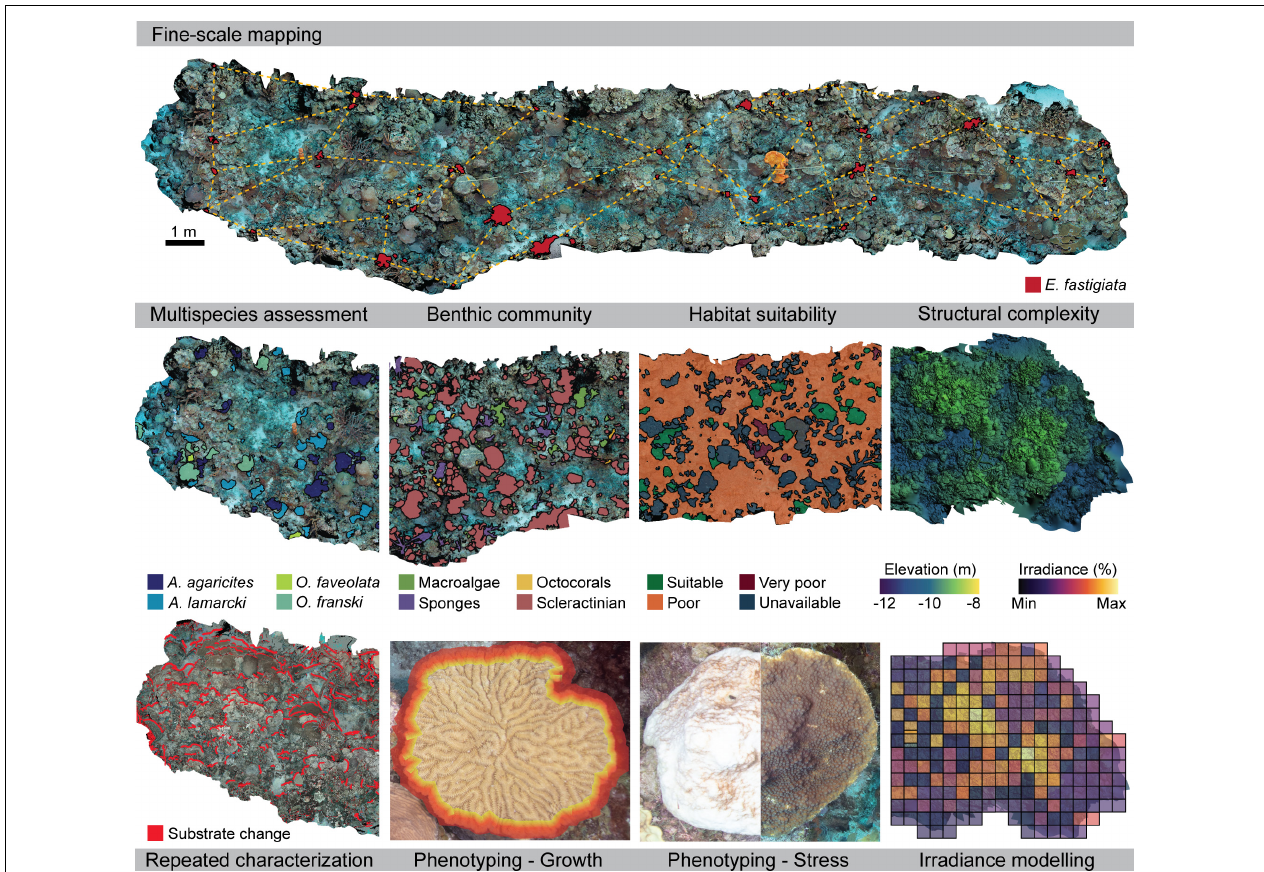
FIGURE 1 | Conceptual diagram summarizing conceptual diagram summarizing different SfM-enabled characterization examples that can be utilized in reefscape genomic studies. The orthoprojection (25 × 4 m) depicts a Caribbean coral reef community at 20 m depth (from the CoralScape project, Curaçao, Southern Caribbean). Fine-scale mapping allows for accurate positioning of target organisms within the reefscape and a priori established sampling designs (depicted here for Eusmilia fastigiata ). It also enables spatially explicit, multi-species assessments (e.g., to characterize broader patterns related to life history or the occurrence and consequences of hybridization). Image-based biotic/abiotic characterization of the reefscape can help elucidate the interaction of dispersal, recruitment, and selection processes with the environment (e.g., considering competitive or mutualistic relationships or habitat suitability). Structural complexity or 3D positioning can be similarly considered or used for environmental or biophysical modeling (e.g., incident irradiance, water flow, sedimentation, or larval dispersal). Repeated characterization allows for spatio-temporal consideration of the reefscape and target organisms, as well as mass-phenotyping of the latter (e.g., growth rates or stress